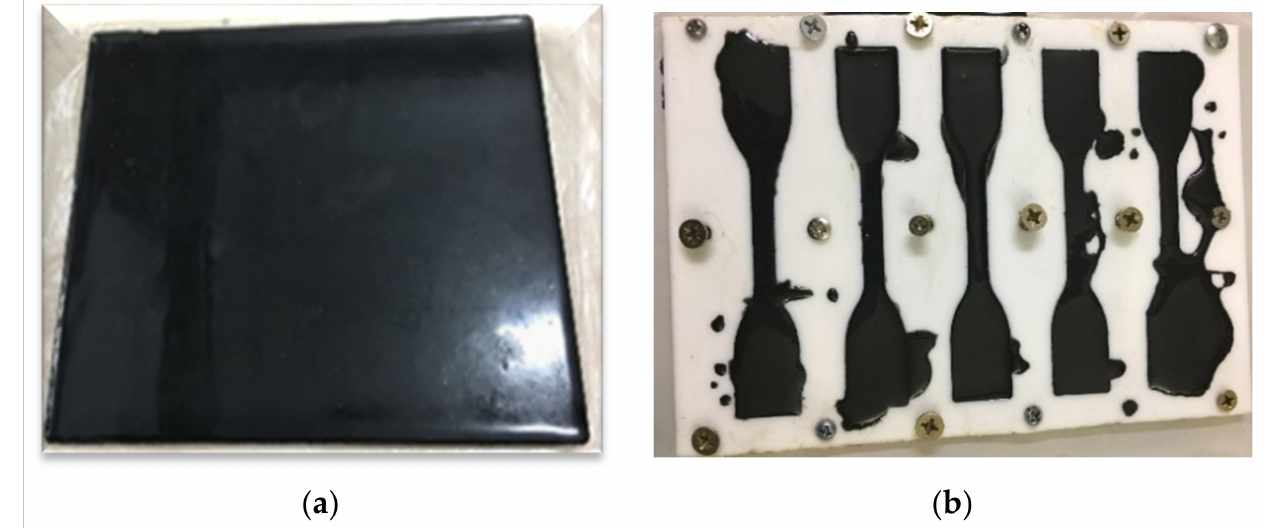
Figure 3. Photographic images of ( a ) Cured epoxy/CNT nanocomposite and ( b ) Uncured epoxy/CNT nanocomposite for the tensile